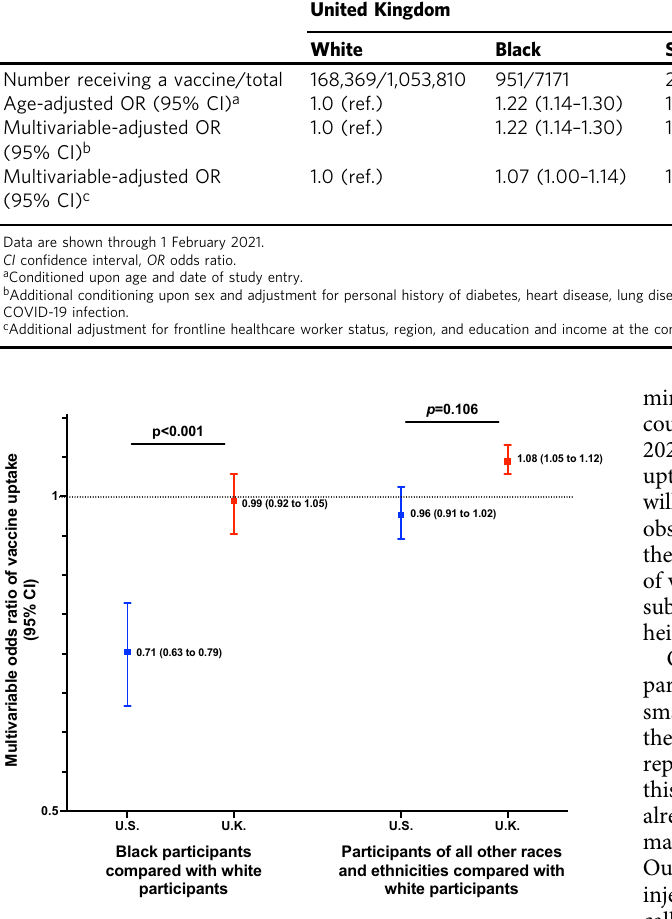
Fig. 1 Disparity in vaccine uptake by race and ethnicity according to country of enrollment. Risk estimates of receiving a vaccine through 1 February 2021 calculated within the country using multivariable logistic regression conditioned upon age, sex, and date of study entry and adjusted for personal history of diabetes, heart disease, lung disease, kidney disease, current smoking status, body mass index, prior reported history of COVID- 19 infection, frontline healthcare worker status, and education and income at the community level. Data are presented as multivariable OR estimates ±95% CI. P interaction was calculated using the Wald test for the cross- product terms between race and ethnicity and country, P interaction = for Black vs. white and 0.106 for all other races and ethnicities compared with white participants, respectively. N = 1,110,544 for white U.K. participants, 64,144 for white U.S. participants, 8787 for Black U.K. participants, 2179 for Black U.S. participants, 35,657 U.K. participants of other races and ethnicities, and 7327 U.S. participants of other races and ethnicities, respectively. Source data are provided with this paper. CI con fi dence interval, OR odds